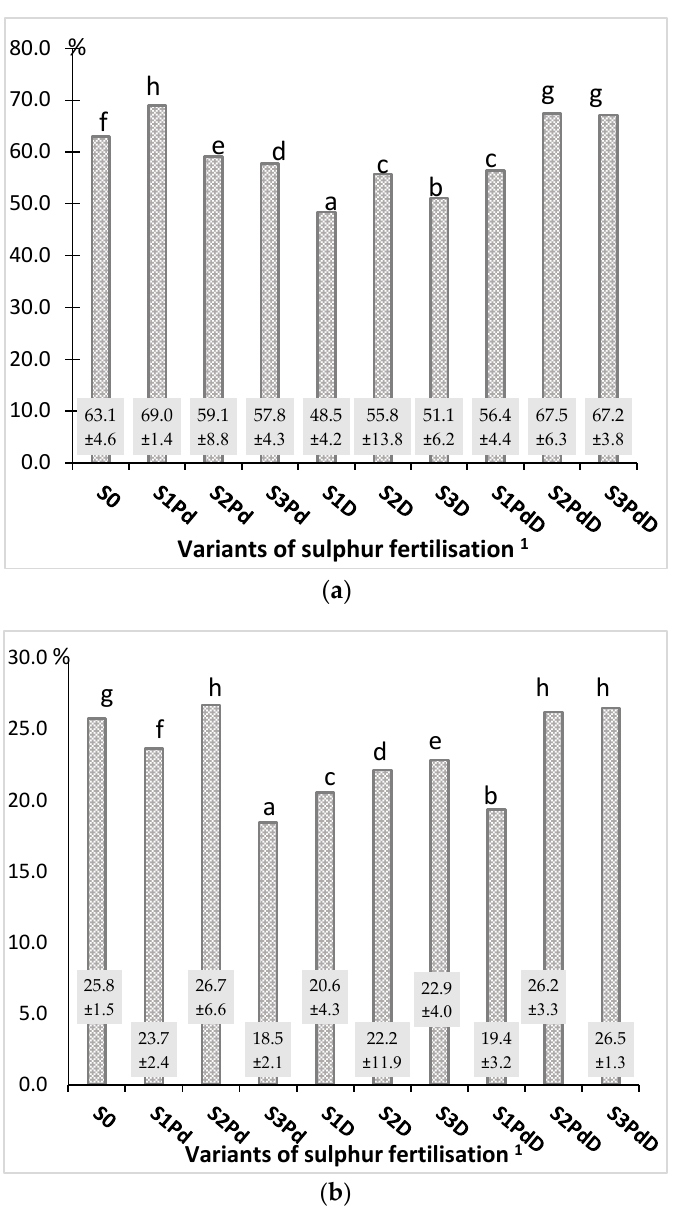
Figure 9. ( a ) Phosphorus harvest index on average for variants of sulphur fertilisation; ( b ) Potassium harvest index on average for variants of sulphur fertilisation. 1 See Table 2; Means followed by the same letter are not statistically different at the α = 0.05 leve l. ±— standard deviation.